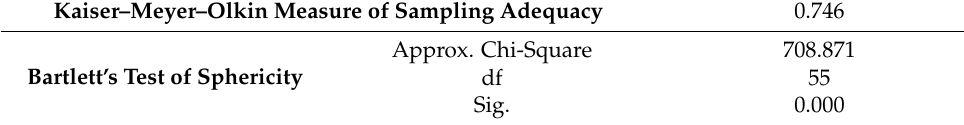
Table 5. KMO and Bartlett’s test.